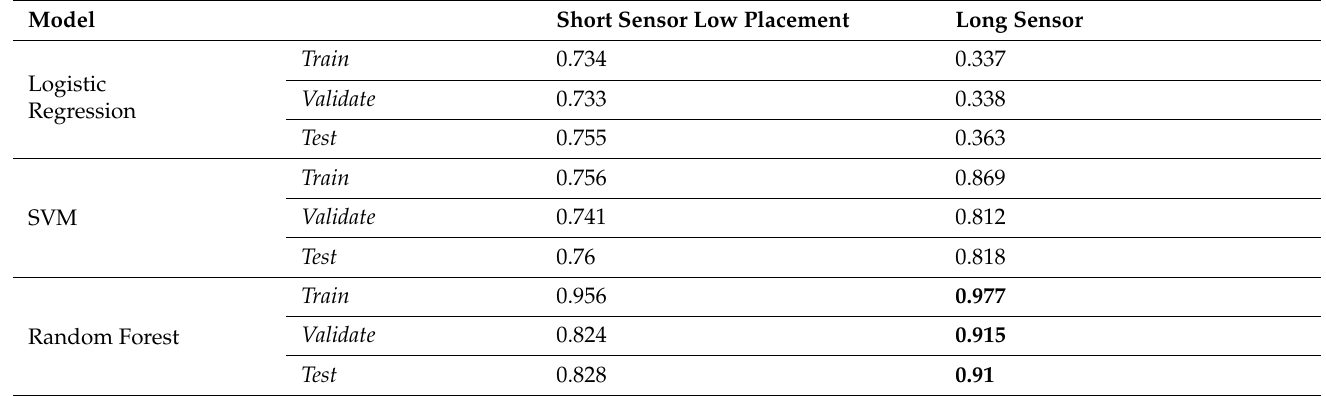
Table 2. Fivefold training, cross-validation, and held-out test accuracy of classical ML models with different feature sets. The bold font denotes the cases with the highest accuracy for that model. These results are for the five-class dictionary that includes facing right and facing left.